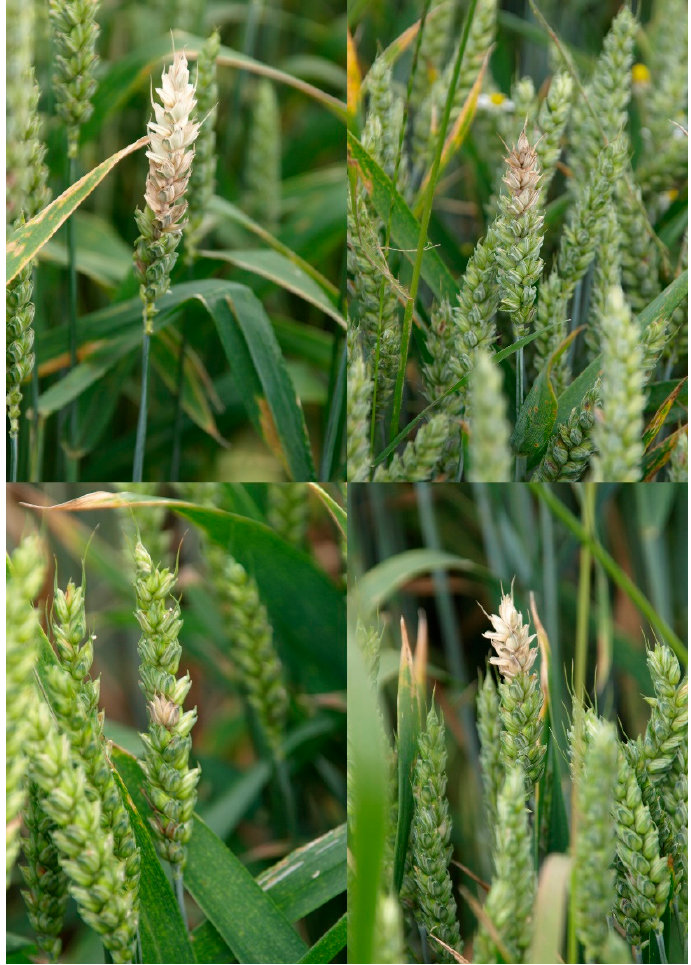
Figure 1. FHB symptoms on heads of wheat grown in organic field. Clockwise from top left: ‘Figura’, ‘Muszelka’, ‘Kampna’, ‘Slade’. Wheat at early milk growth stage (BBCH 73).